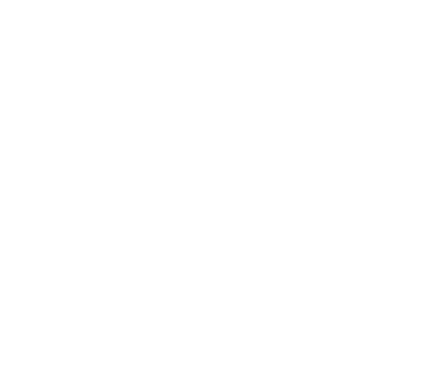
Table 3. mRNA expression of mucin genes in the different pancreatic ductal cell lines.